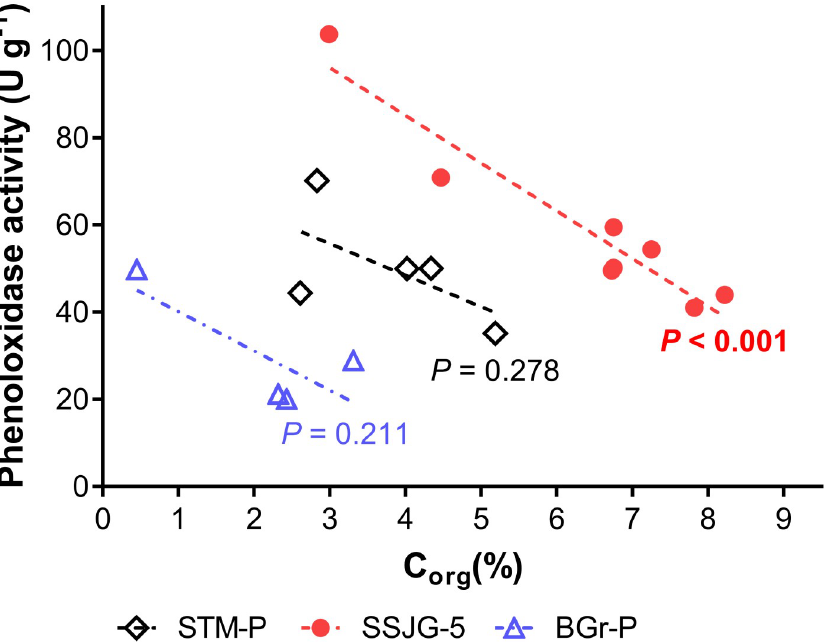
Fig 4. Extracellular phenoloxidase activity versus organic C content across sample sites. STM-P (R 2 = 0.37), SSJG-5 (R 2 = 0.91), and BGr-P (R 2 = 0.62).